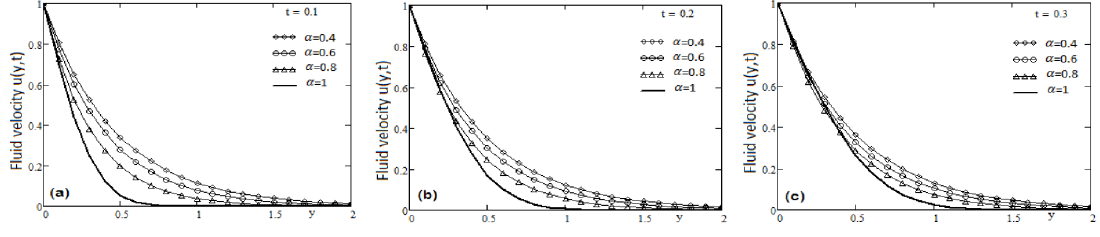
Figure 1. Profiles of velocities for fractional parameter variation for different small time and fixed Reynolds number Re =